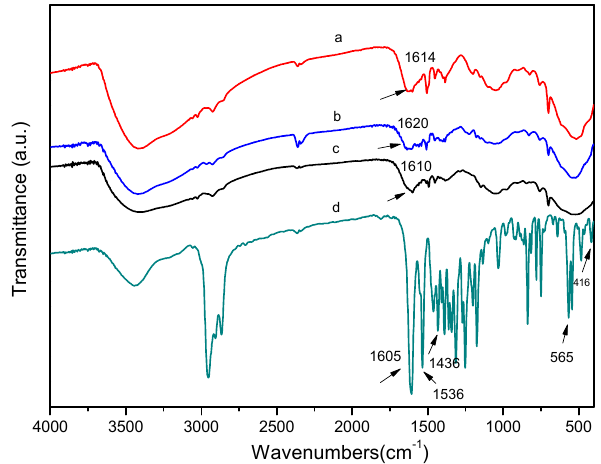
Figure 1. FT-IR spectra of catalysts. ( a ) Catalyst 1, ( b ) catalyst 2, ( c ) catalyst 3, ( d ) chiral Mn III (salen) complex.